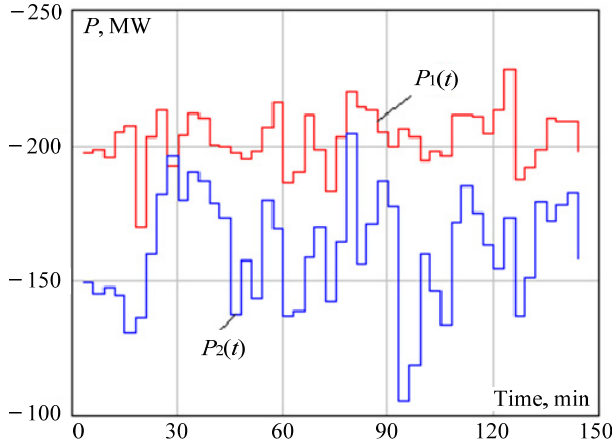
Figure 3. Load graphs. Following expressions (8) and (9), the sign of the load powers is taken as negative.